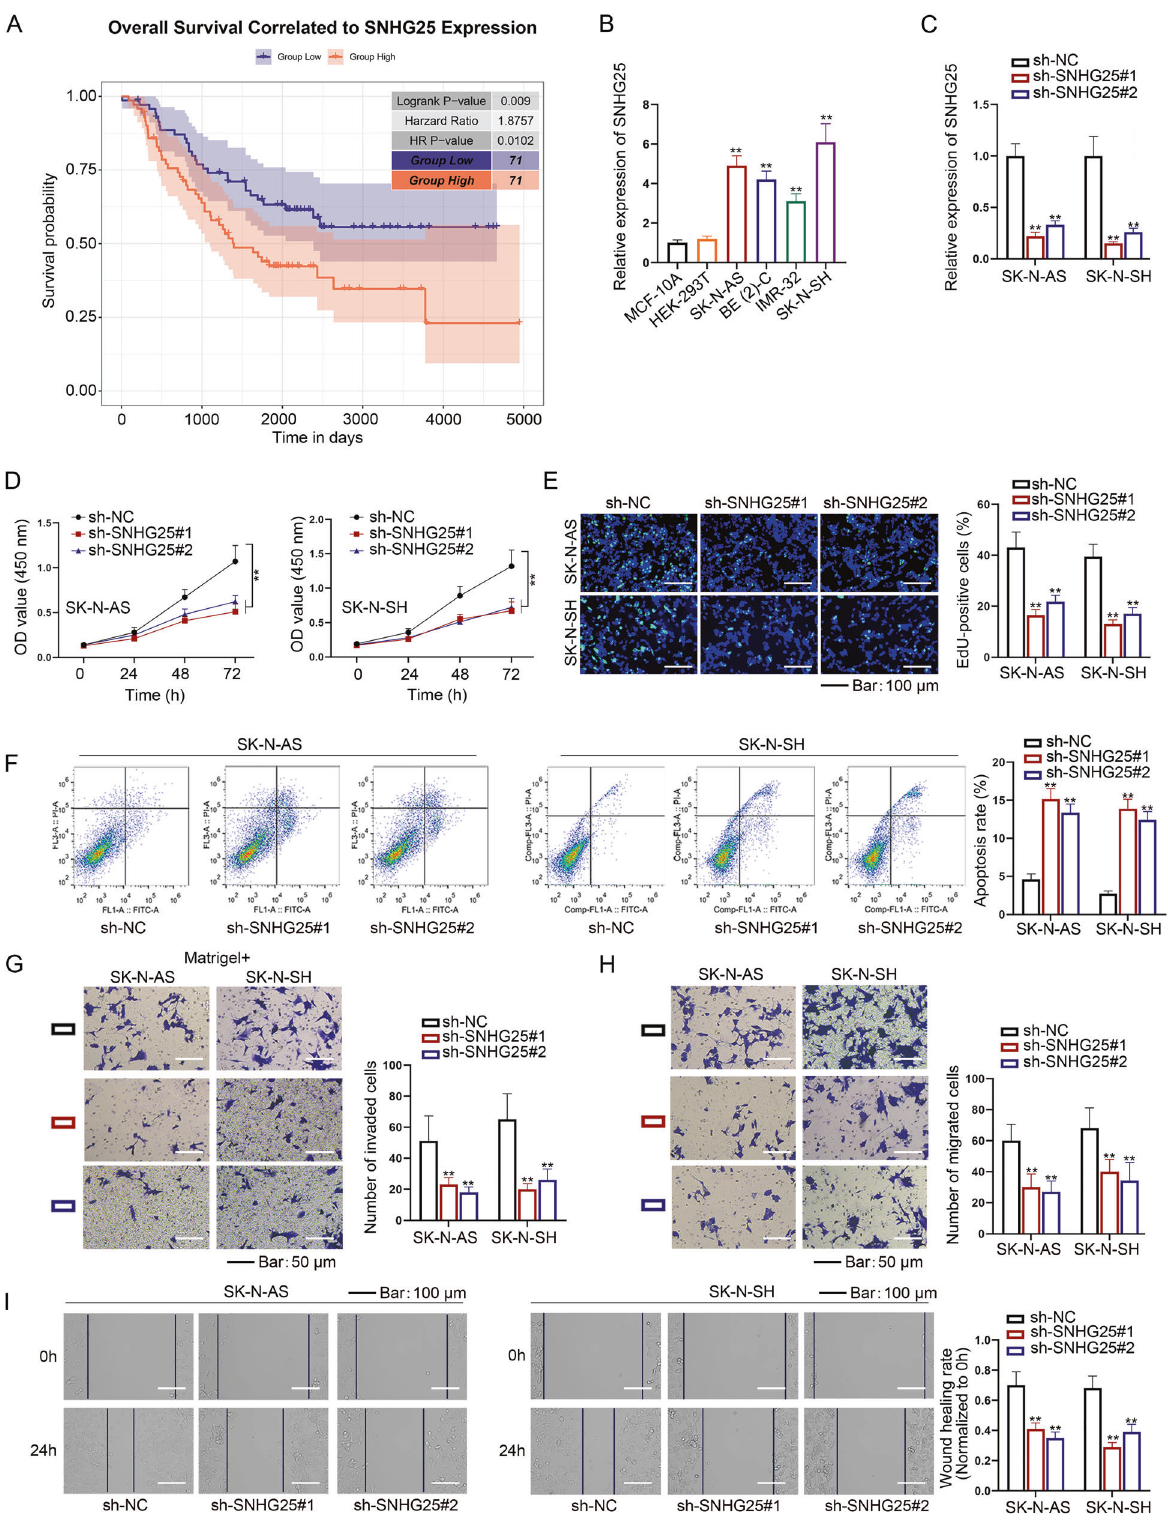
Fig. 1 SNHG25 promotes the proliferation, migration, and invasion of NB cells. A SNHG25 expression was analyzed in NBL tissues and normal neural tissues from the combined cohort of TCGA TARGET GTEx in UCSC-XENA. B SNHG25 expression in NB cell lines, MCF-10A, and HEK-293T cells were detected by RT-qPCR. (One-way ANOVA, Tukey) C The interference ef fi ciency of sh-SNHG25 was detected in SK-N-AS and SK-N-SH cells by RT-qPCR. (One-way ANOVA, Dunnett) D – F CCK-8 assay, colony formation assay, and fl ow cytometry analysis detected proliferation and apoptosis of NB cells with SNHG25 silence. (One-way ANOVA, Dunnett) G – I Transwell and wound healing assays detected invasion and migration of NB cells with SNHG25 silence. (One-way ANOVA, Dunnett) ** P < 0.01. Error bars indicate mean ± SD. ( N = 3).